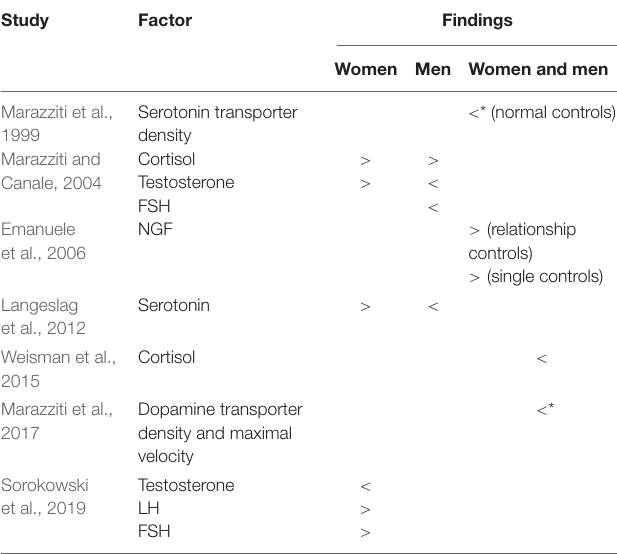
TABLE 2 | Significant results of controlled endocrine studies investigating romantic